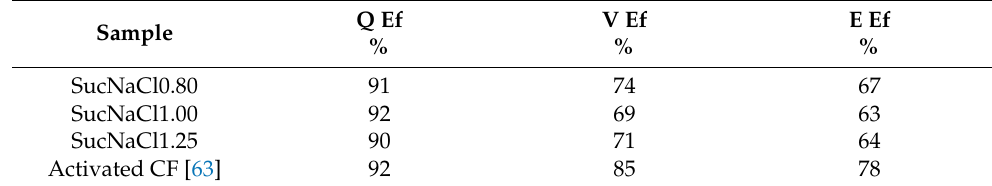
Table 3. Coulombic (Q), energy (E) and voltage (V) efficiencies (Ef) for the charge–discharge of the VRFB at a current density of 20 mA · cm − 2 (calculated as the average of the ten first cycles after GCD at several current